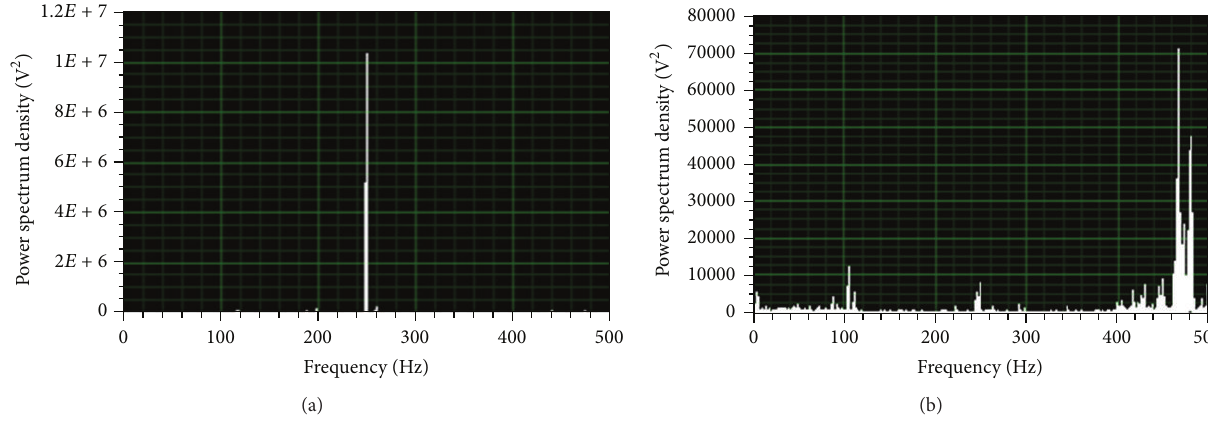
Figure 9: The power spectrum density of corresponding acceleration signals before and after imposing